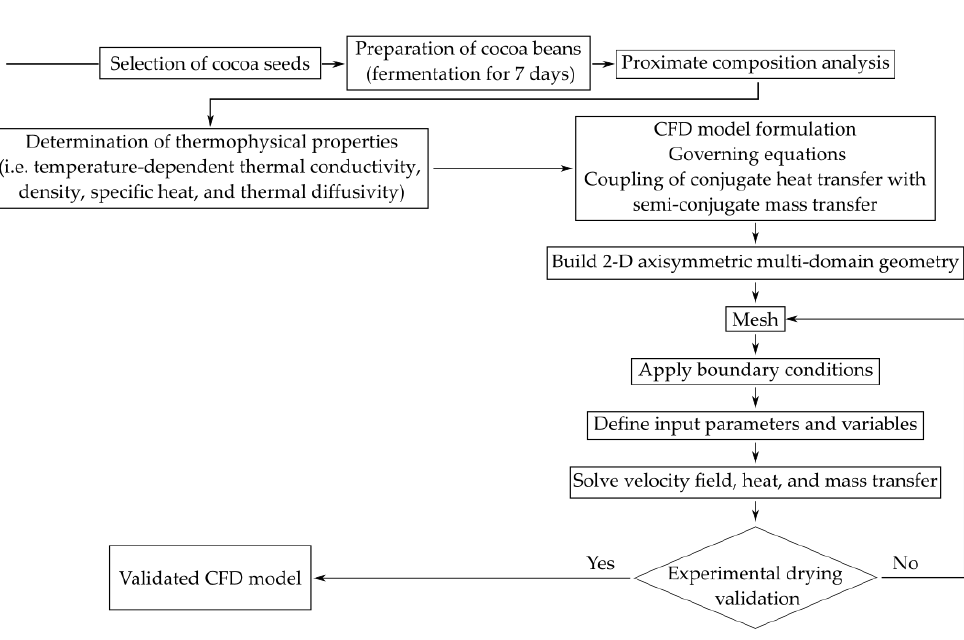
Figure 3. The overall experimental and computational procedure.